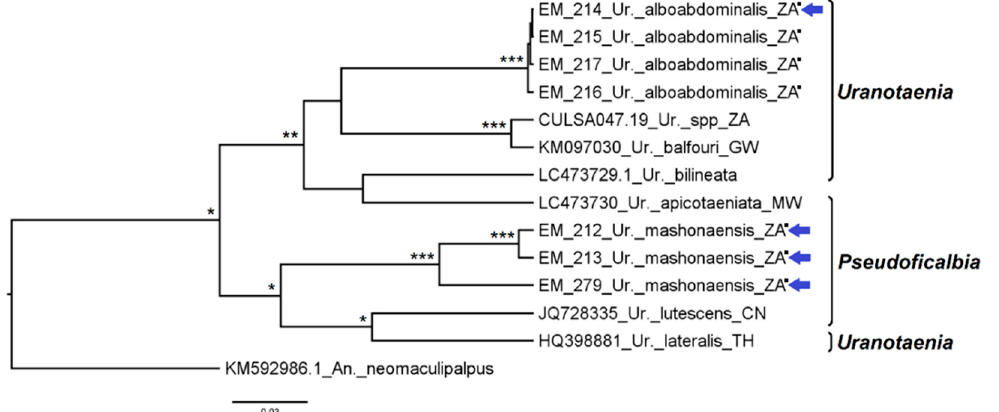
Figure 18. Phylogenetic analysis of 13 partial coxI nucleotide sequences from mosquitoes of the genus Uranotaenia. At specific branches, the number of * indicates the tree topological support revealed by the different phylogenetic reconstruction methods, assuming relevant bootstrap and aLRT values above 75% and posterior probability values above 0.80. The sequences obtained in this work are indicated by the “EM” code and those with associated genitalia are indicated by horizontal blue arrows. The sequences downloaded from GenBank and Boldsystems are indicated by their respective accession numbers and access codes (respectively); the symbol “.” after the code of our sequence indicates that said sequence was not identified by Boldsystems. Their country of origin [South Africa (ZA), China (CN), Guinea-Bissau (GW), Malawi (MW), Thailand (TH)] are also indicated. The vertical lines mark the subgenera Uranotaenia and